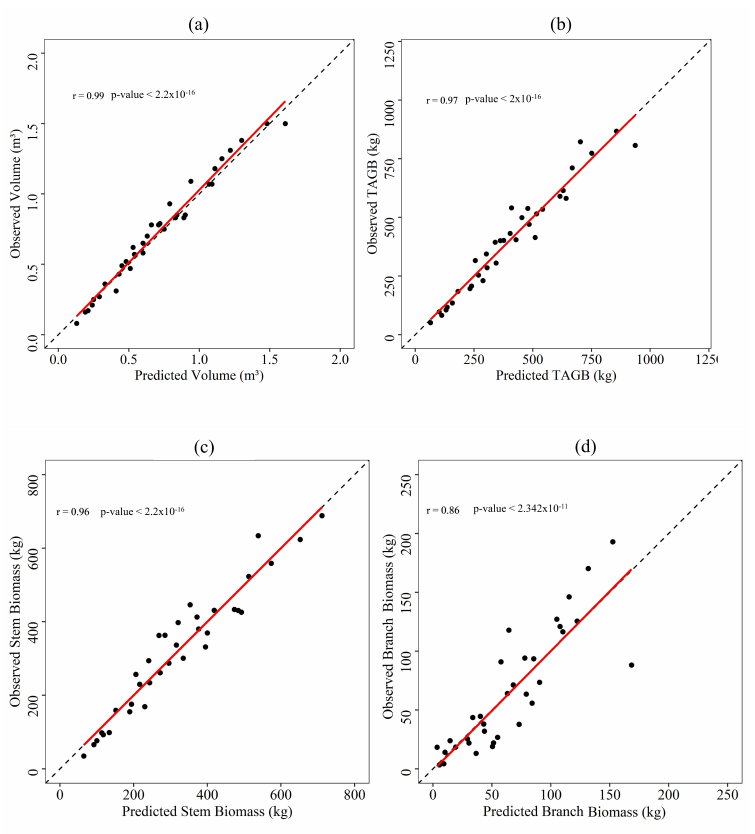
Figure 3. Relationship between observed and predicted tree volume (v) ( a ); total aboveground biomass (TAGB) ( b ); stem biomass (SAGB) ( c ); and branch biomass (BAGB) ( d